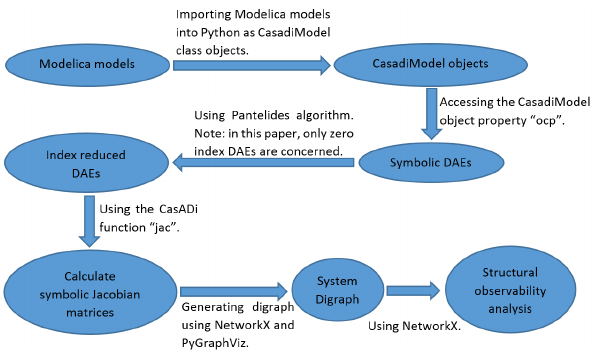
Figure 6: Structure of the Python